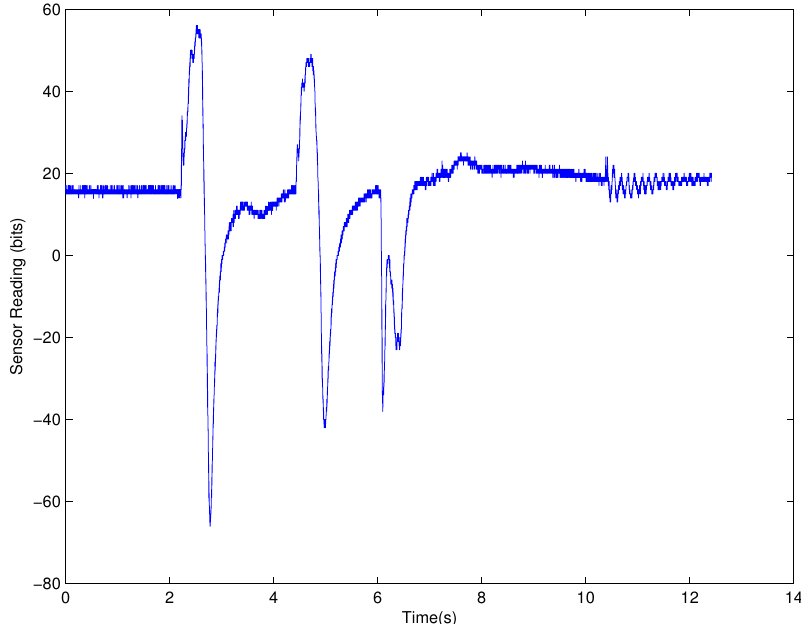
Figure 8. Sensor measurements from test using robotic arm with